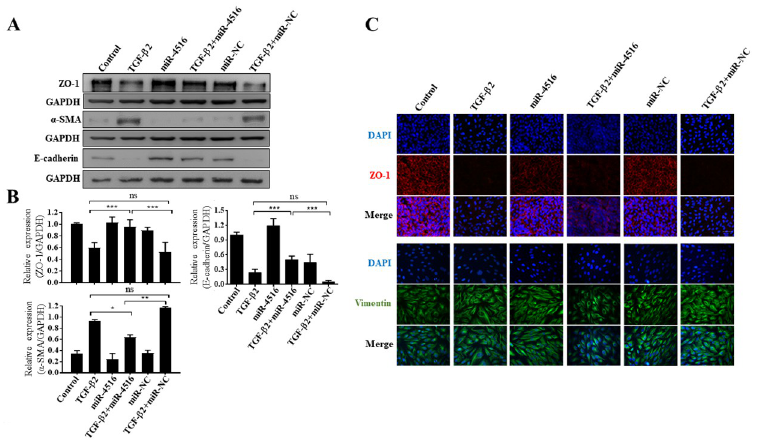
Fig 3. Expression of EMT-related biomarkers in ARPE-19 cells treated with TGF- β 2 through miR-4516 delivery. (A) Immunoblot analyses of the effects of miR-4516 overexpression on the expression of α -SMA, ZO-1, and E- cadherin during TGF- β 2-induced EMT in the ARPE-19 cells. (B) Quantification of the immunoblot data is shown in (A). Three independent experiments were performed. Data are presented as the means ± standard errors of the mean. � p < 0.05; �� p < 0.01; ��� p < 0.001; ns: not significant according to an independent one-way analysis of variance. (C) Representative images of immunostained fibroblastic (vimentin) and ZO-1 in ARPE-19 cells transfected with negative control or an miR-4516 mimic and treated with TGF- β 2 for 48 h. Nuclei were stained with 4 0 ,6-diamidino-